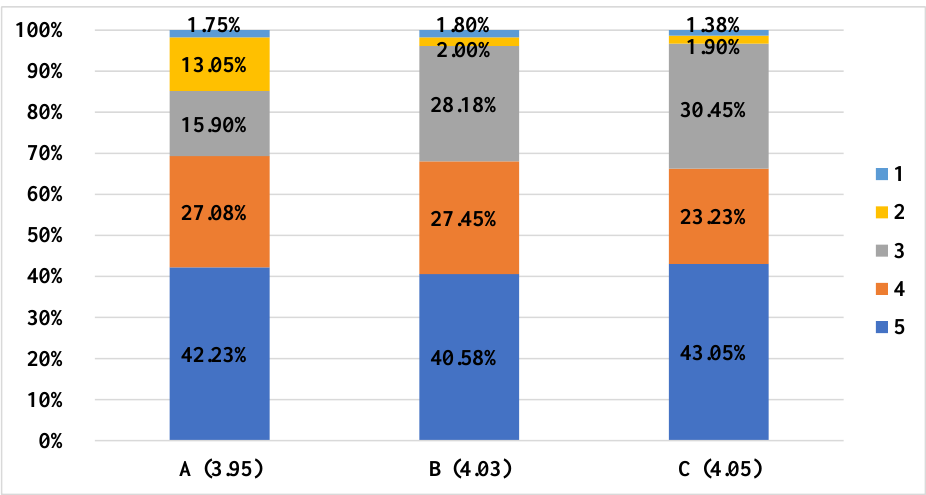
Figure 4. Manual evaluation outcomes for Japanese → Chinese